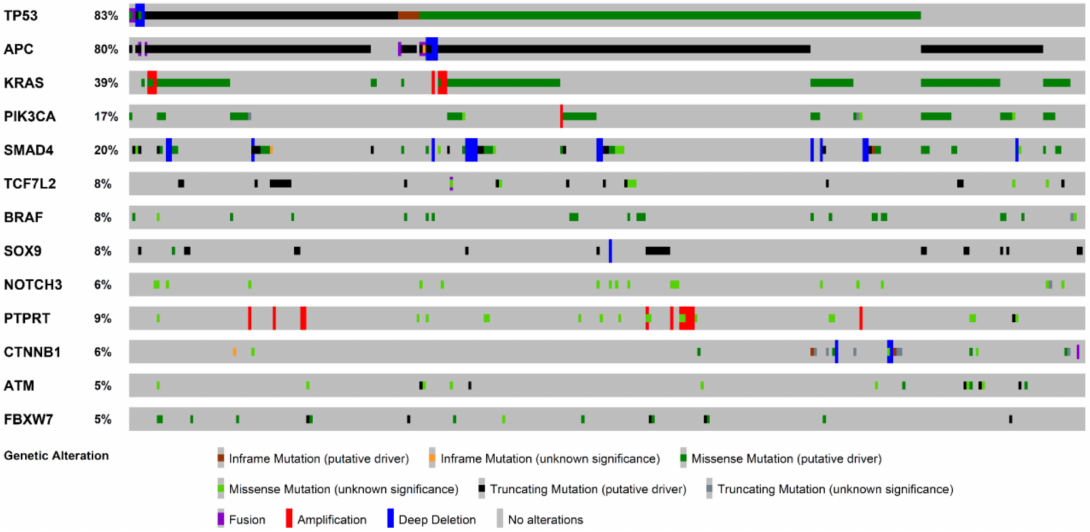
Figure 1. Oncoprint visualization of highly recurrent somatic molecular alterations by frequency in colorectal cancer liver metastases (313 patients, 319 samples from cBioPortal). Each row represents a gene, as reported on the left; types of alterations are color-coded on the basis of the legend on the bottom.